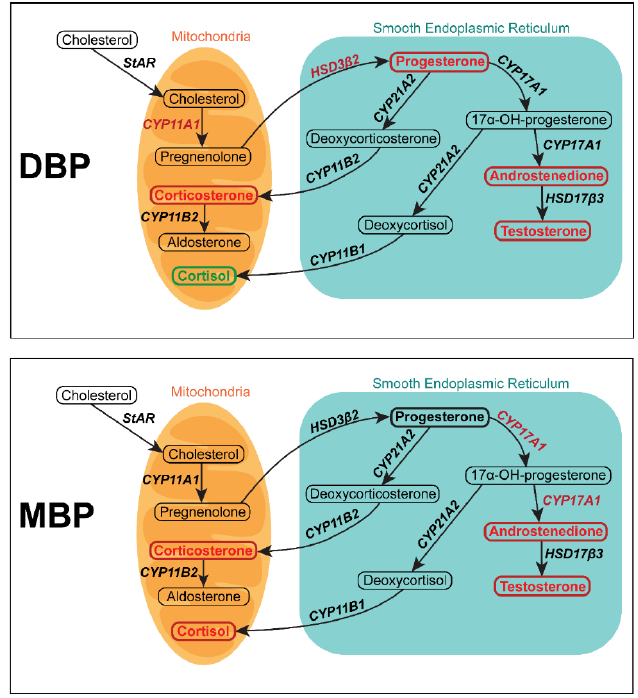
Figure 9. Summary of the effects of DBP (top) and MBP (bottom) exposure on steroidogenesis in H295R cells. Steroid hormones are written inside boxes, and enzymes are written in italic. Hormones and enzymes quantified are marked in bold , where red signifies a significant decrease, green a significant increase, and black no significant changes.